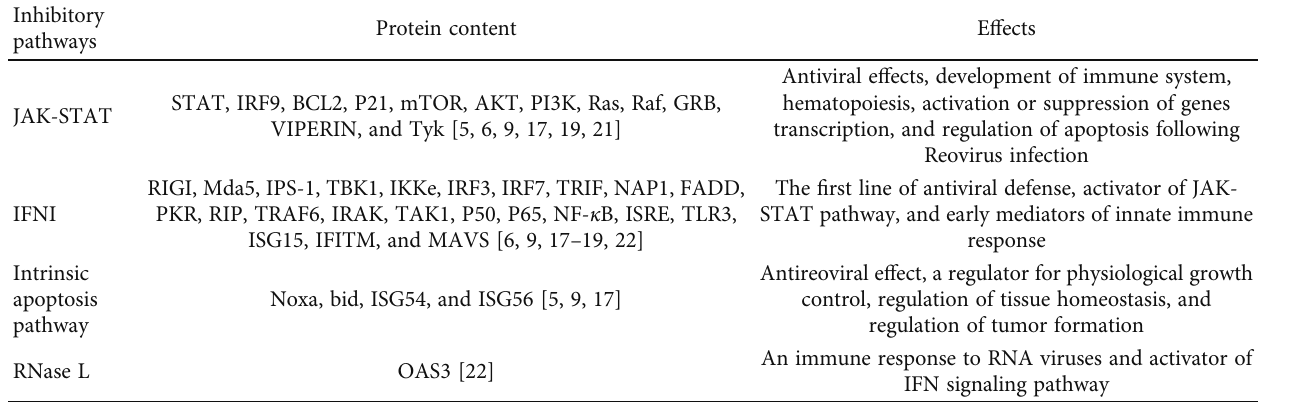
Table 1: The probable immune system proteins which interfere with reovirus